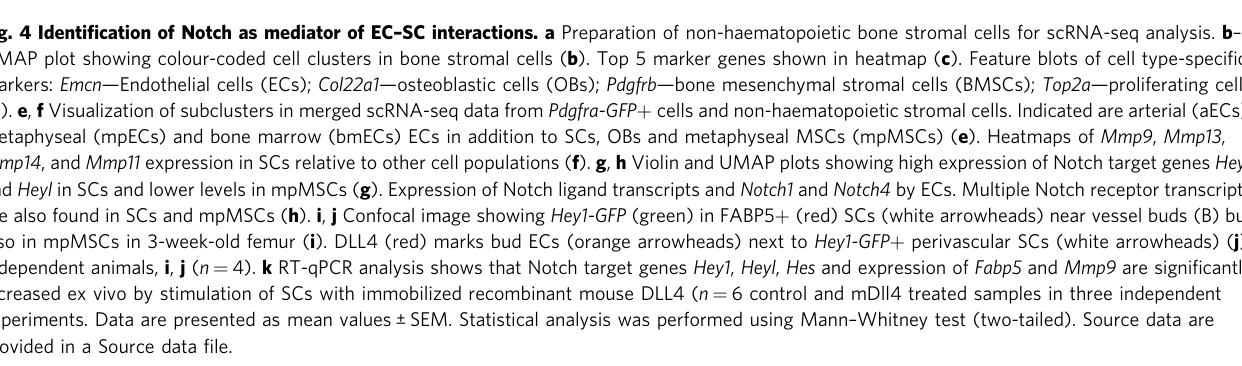
Fig. 4 Identi fi cation of Notch as mediator of EC – SC interactions. a Preparation of non-haematopoietic bone stromal cells for scRNA-seq analysis. b – d UMAP plot showing colour-coded cell clusters in bone stromal cells ( b ). Top 5 marker genes shown in heatmap ( c ). Feature blots of cell type-speci fi c markers: Emcn — Endothelial cells (ECs); Col22a1 — osteoblastic cells (OBs); Pdgfrb — bone mesenchymal stromal cells (BMSCs); Top2a — proliferating cells ( d ). e , f Visualization of subclusters in merged scRNA-seq data from Pdgfra-GFP + cells and non-haematopoietic stromal cells. Indicated are arterial (aECs), metaphyseal (mpECs) and bone marrow (bmECs) ECs in addition to SCs, OBs and metaphyseal MSCs (mpMSCs) ( e ). Heatmaps of Mmp9 , Mmp13 , Mmp14 , and Mmp11 expression in SCs relative to other cell populations ( f ). g , h Violin and UMAP plots showing high expression of Notch target genes Hey1 and Heyl in SCs and lower levels in mpMSCs ( g ). Expression of Notch ligand transcripts and Notch1 and Notch4 by ECs. Multiple Notch receptor transcripts are also found in SCs and mpMSCs ( h ). i , j Confocal image showing Hey1-GFP (green) in FABP5 + (red) SCs (white arrowheads) near vessel buds (B) but also in mpMSCs in 3-week-old femur ( i ). DLL4 (red) marks bud ECs (orange arrowheads) next to Hey1-GFP + perivascular SCs (white arrowheads) ( j ). increased ex vivo by stimulation of SCs with immobilized recombinant mouse DLL4 ( n = 6 control and mDll4 treated samples in three independent provided in a Source data